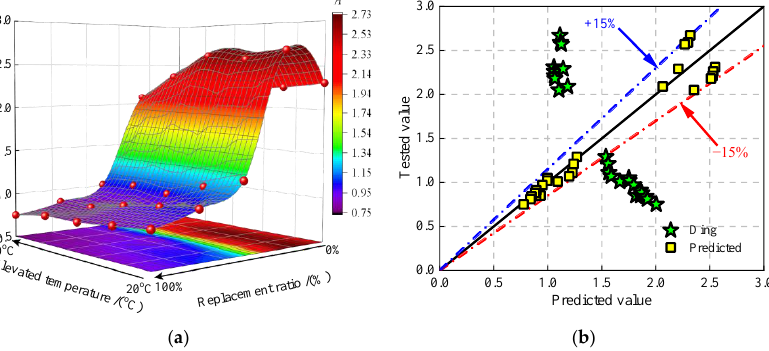
Figure 13. The values of ascending branch parameter A for JNC. ( a ) Surface of A under the effect of replacement ratios and elevated temperatures. ( b ) Comparison of the tested values and the predicted values [37].